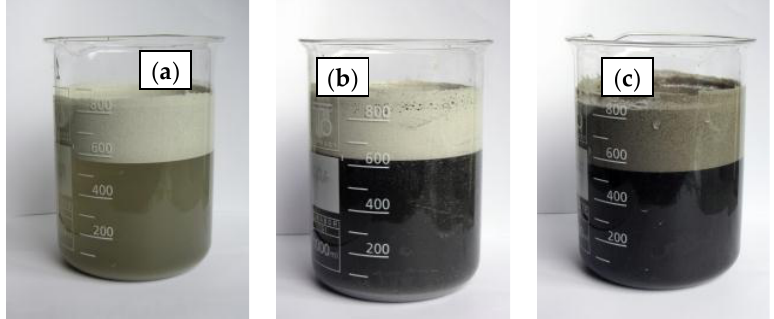
Figure 3. Images of beakers with water and CS1 ( a ), CS2 ( b ), and CS3 ( c ), showing the setup used to separate the broken and intact particles.